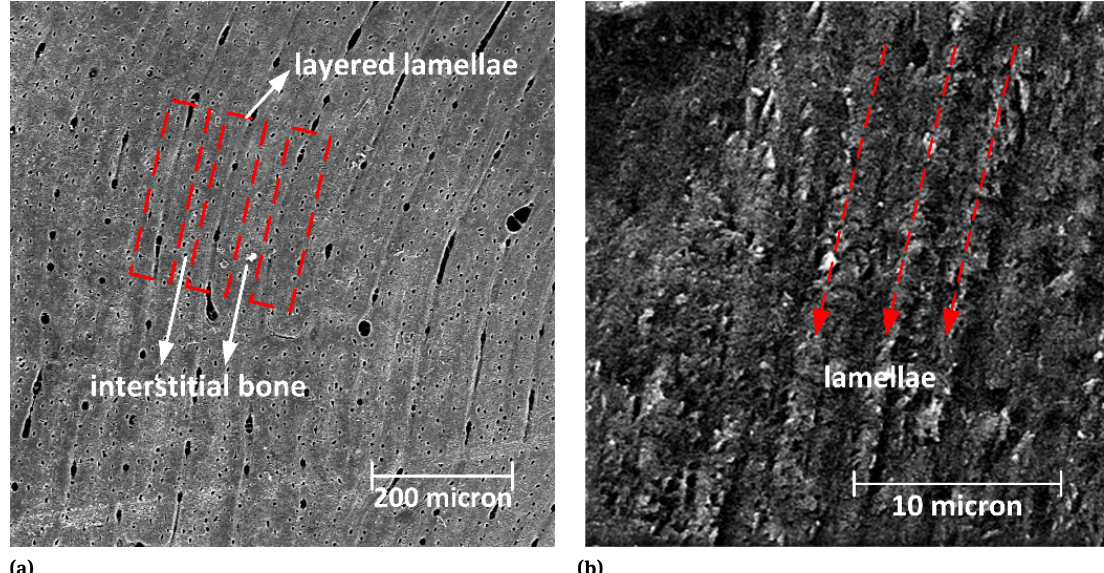
Figure 6: The SEM images of the outer region of cortical bone without loading. (a) The red dotted rectangles show parts of the layered lamellae, and the interstitial bone is between the red dotted rectangles; (b) The red dotted arrows show the orientation of three adjacent lamellae in the layered